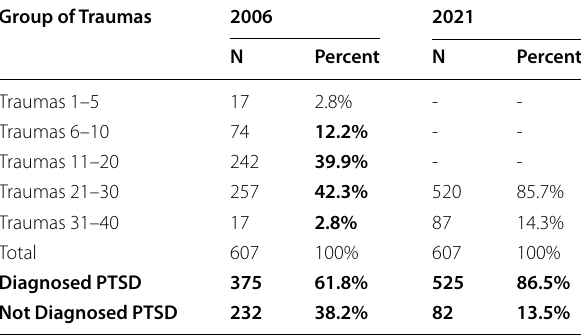
Table 1 Percentages of exposure to group of traumas in 2006